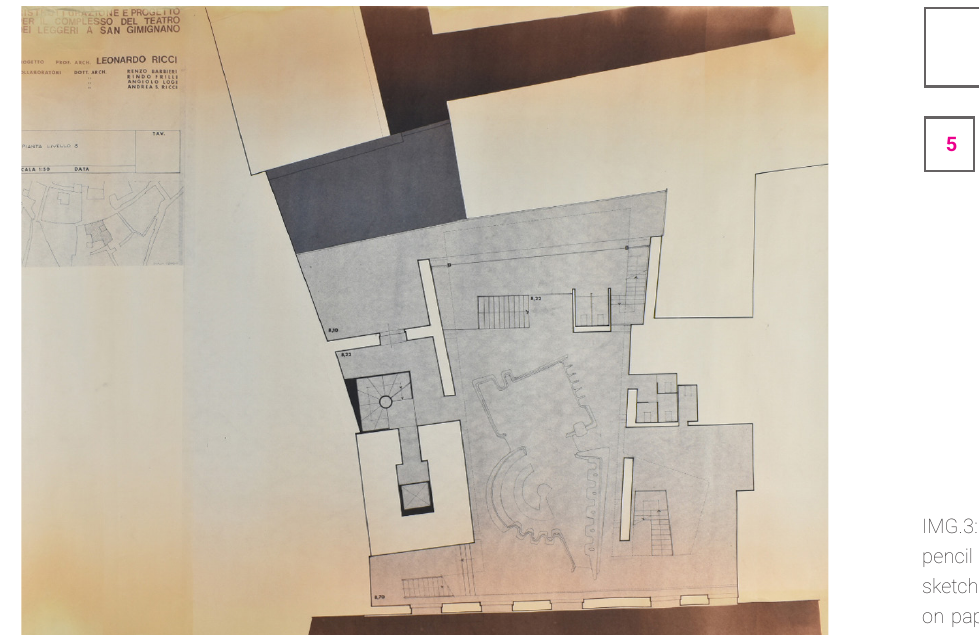
IMG.3: sketch of the section, pencil on paper, CSR; IMG.4: sketch of the section, pencil on paper, CSR; IMG.5: general plan, heliographic copy,